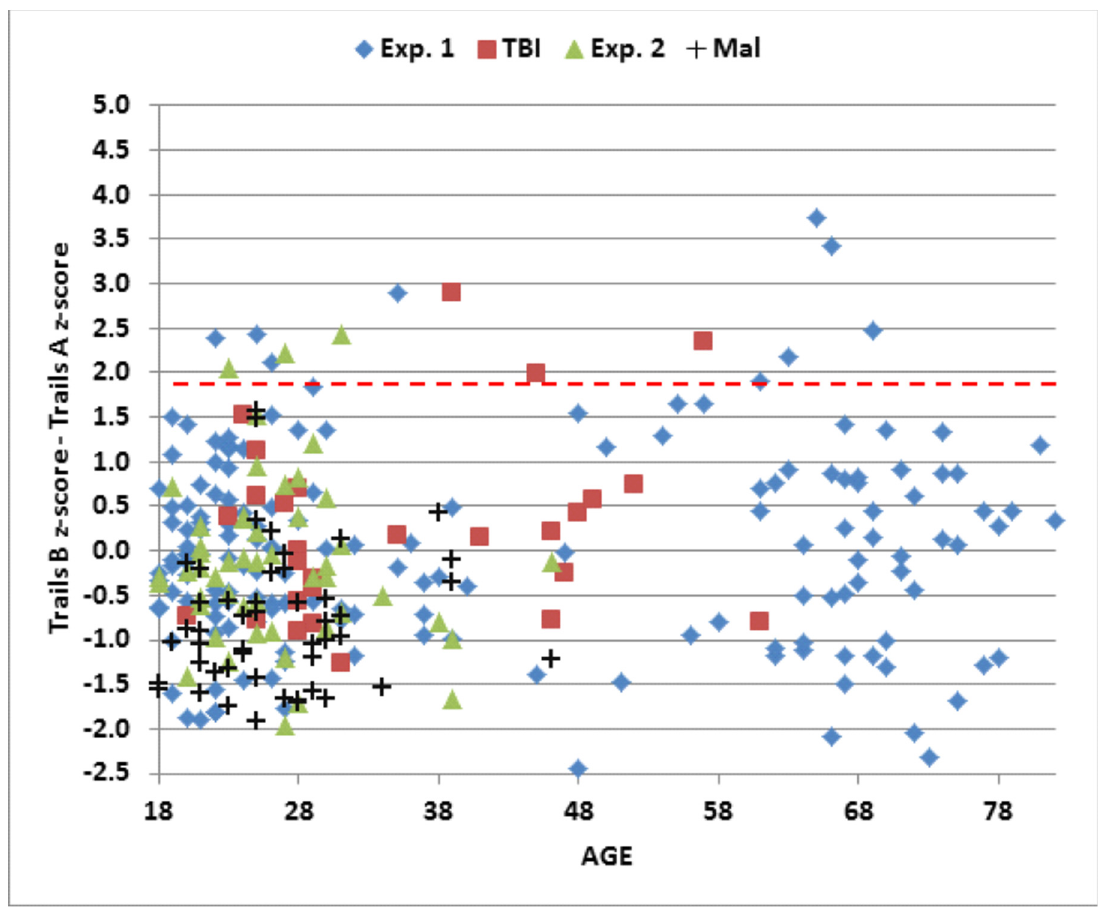
Fig 8. Difference z-scores (C-TMT-B minus C-TMT-A) for subjects of different ages. The dashed horizontal line shows the p < 0.05 abnormality threshold.